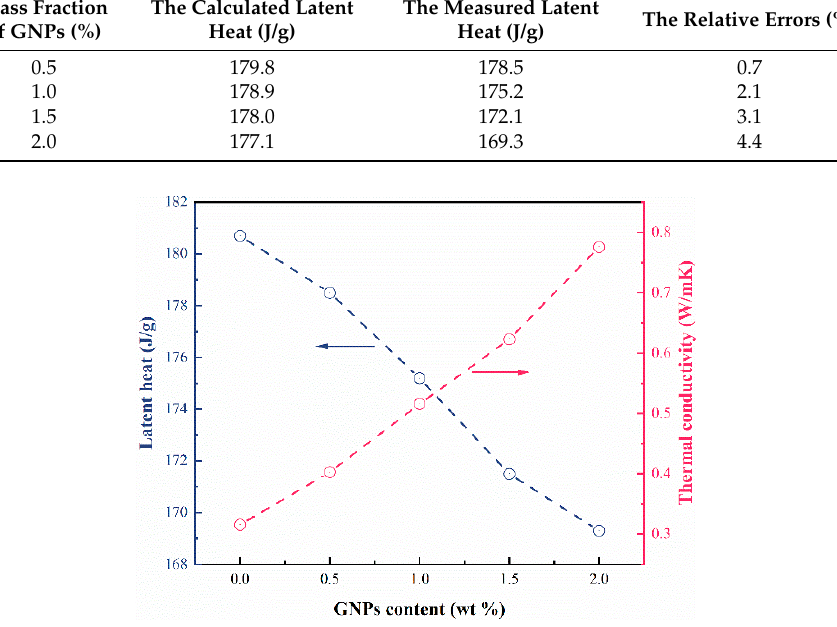
Figure 6. The latent heat and thermal conductivity of the composite as a function of GNPs contents.